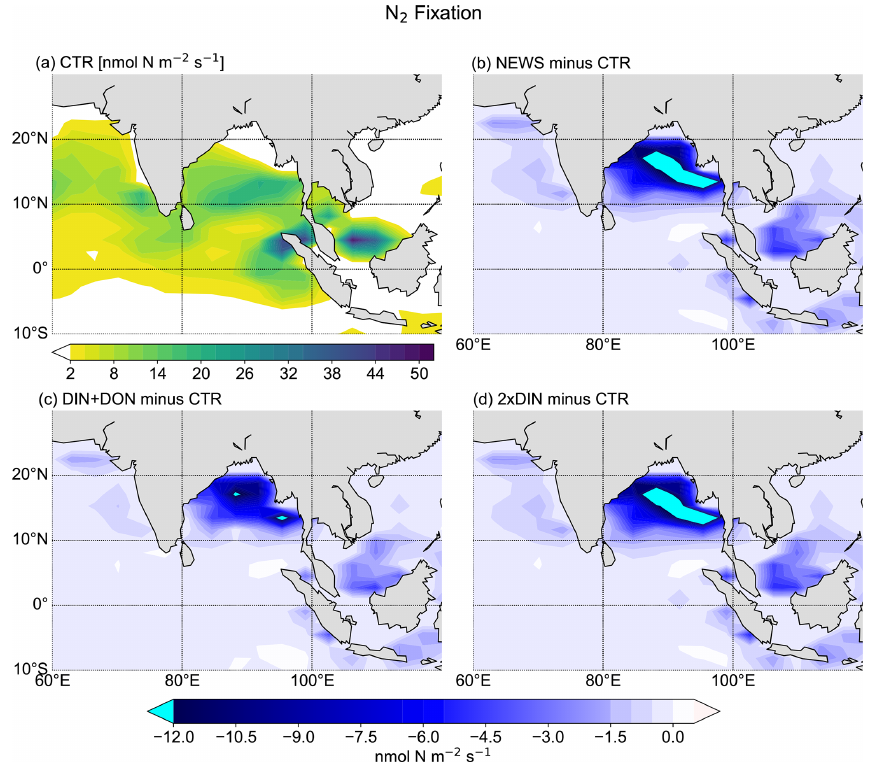
Figure 11. N 2 fixation in the Bay of Bengal. (a) N 2 fixation from CTR in nmolNm − 2 s − 1 . The white color indicates regions where N 2 fixation is smaller than 2nmolNm − 2 s − 1 . (b) Difference in N 2 fixation between NEWS and CTR. (c) Difference in N 2 fixation between DIN + DON and CTR. (d) Difference in N 2 fixation between 2 × DIN and CTR. Table 6. Total NPP, N 2 fixation, and total denitrification from all simulations compared to CTR in some regions with significant decrease or increase in NPP as seen in Fig. 12. NPP is shown in gCyr − 1 and N 2 and denitrification in TgNyr − 1 . Region NPP N 2 fixation Denitrification NEWS DIN + DON 2 × DIN NEWS DIN + DON 2 ×